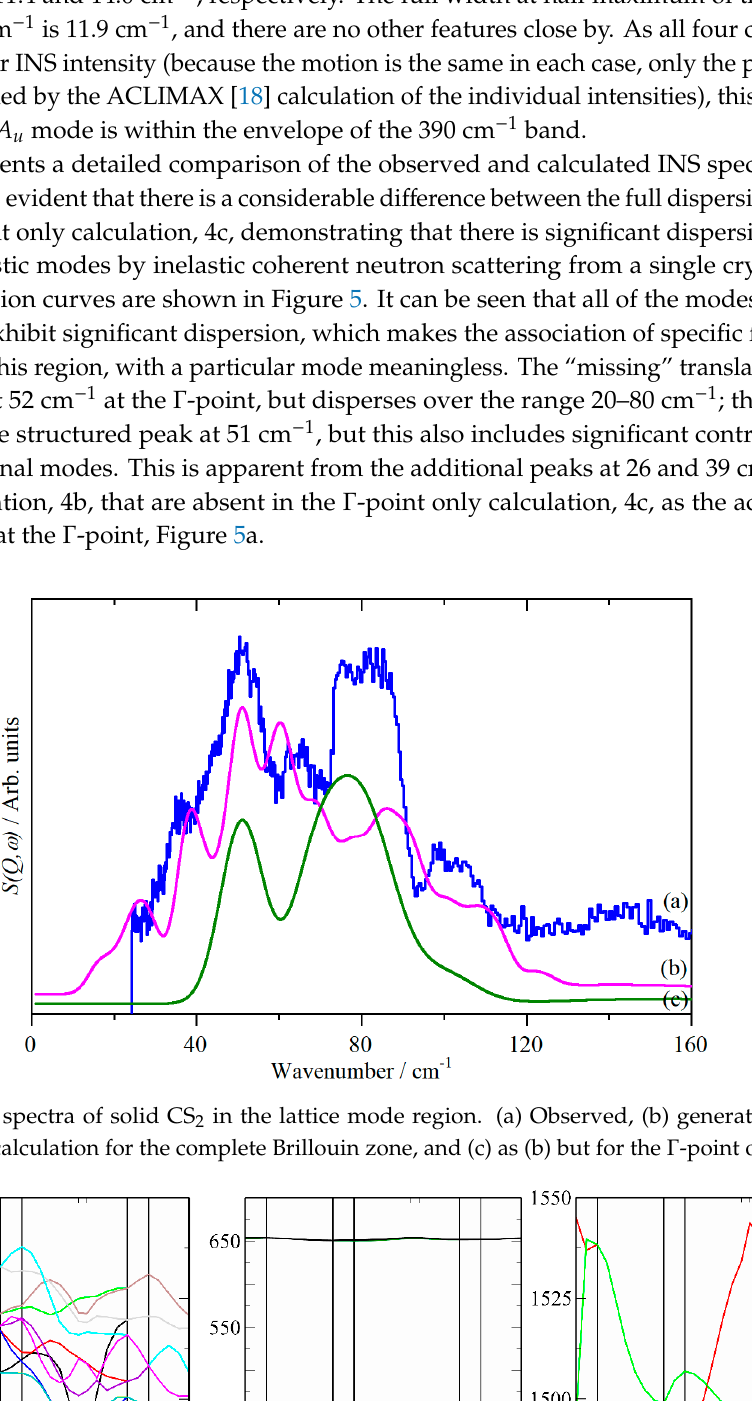
Table 1. Observed and calculated (at the Γ -point) transition energies and intensities of the fundamental modes of CS 2 .